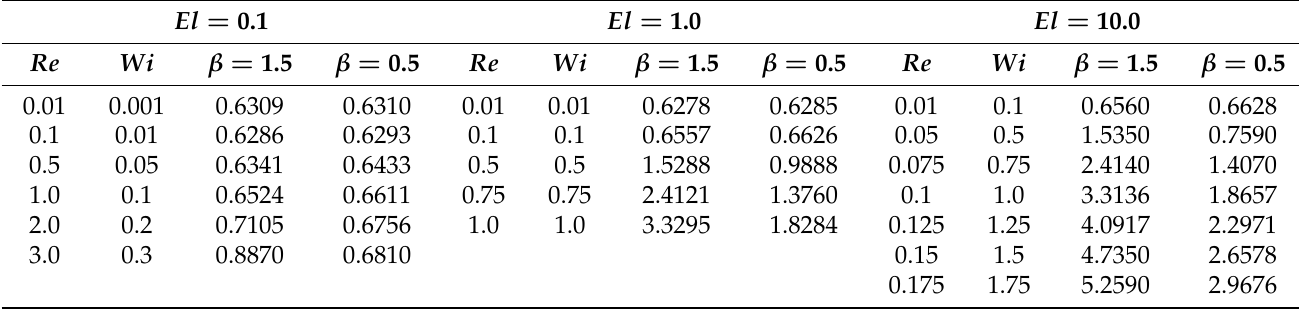
Table 4. Influence of the Elasticity number, El = Wi , α = El = 10.0 for L 99%